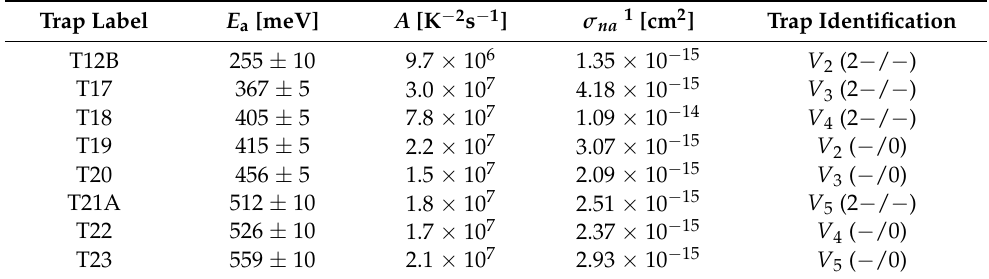
Table 1. Values of the thermal emission activation energy ( E a ), pre-exponential factor in the Arrhenius equation ( A ), and apparent electron capture cross-section for deep traps found by Laplace PITS in HPSi irradiated with 24-MeV protons. The assignment of traps to the energy levels of small vacancy clusters formed under the irradiation is